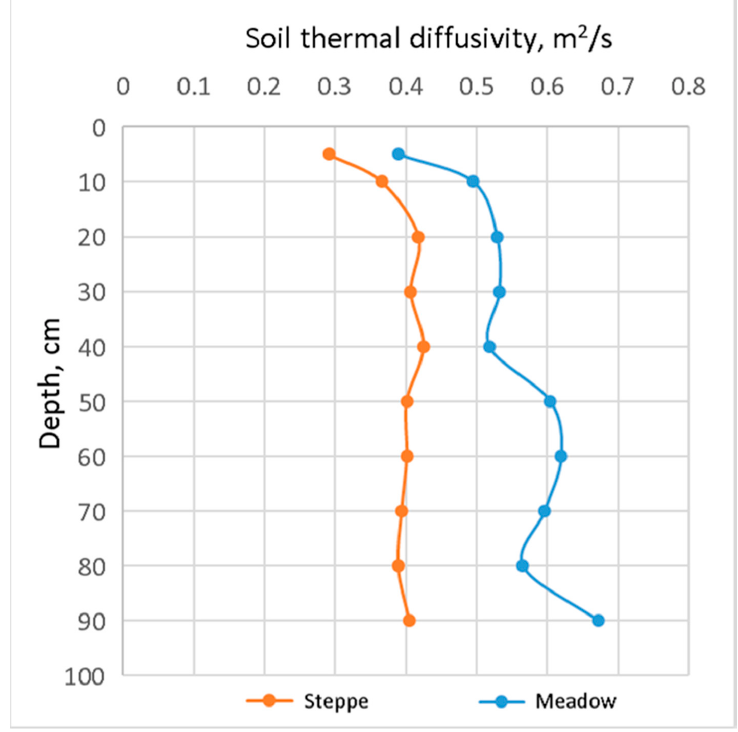
Figure 8. The change in the coefficient of thermal diffusivity of alas steppe and meadow soils. The t